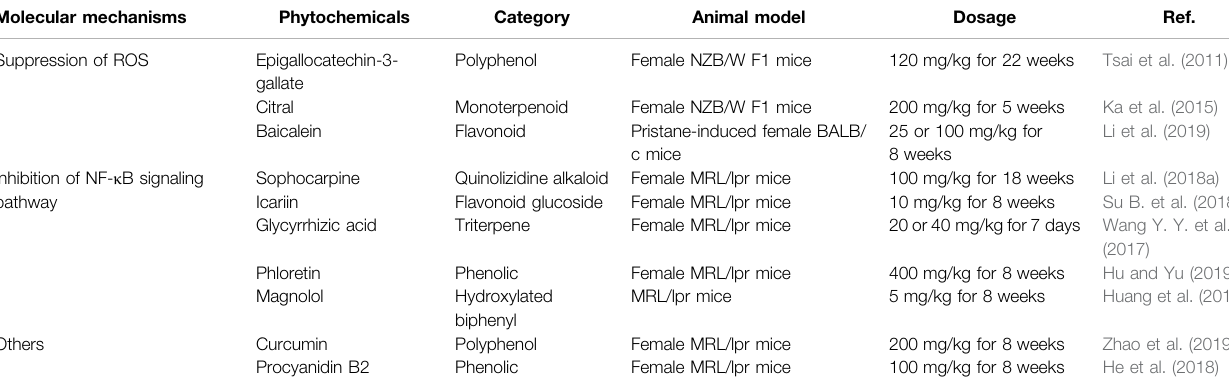
TABLE 2 | Studies on phytochemicals inhibiting NLRP3 in fl ammasome activation in LN. Molecular